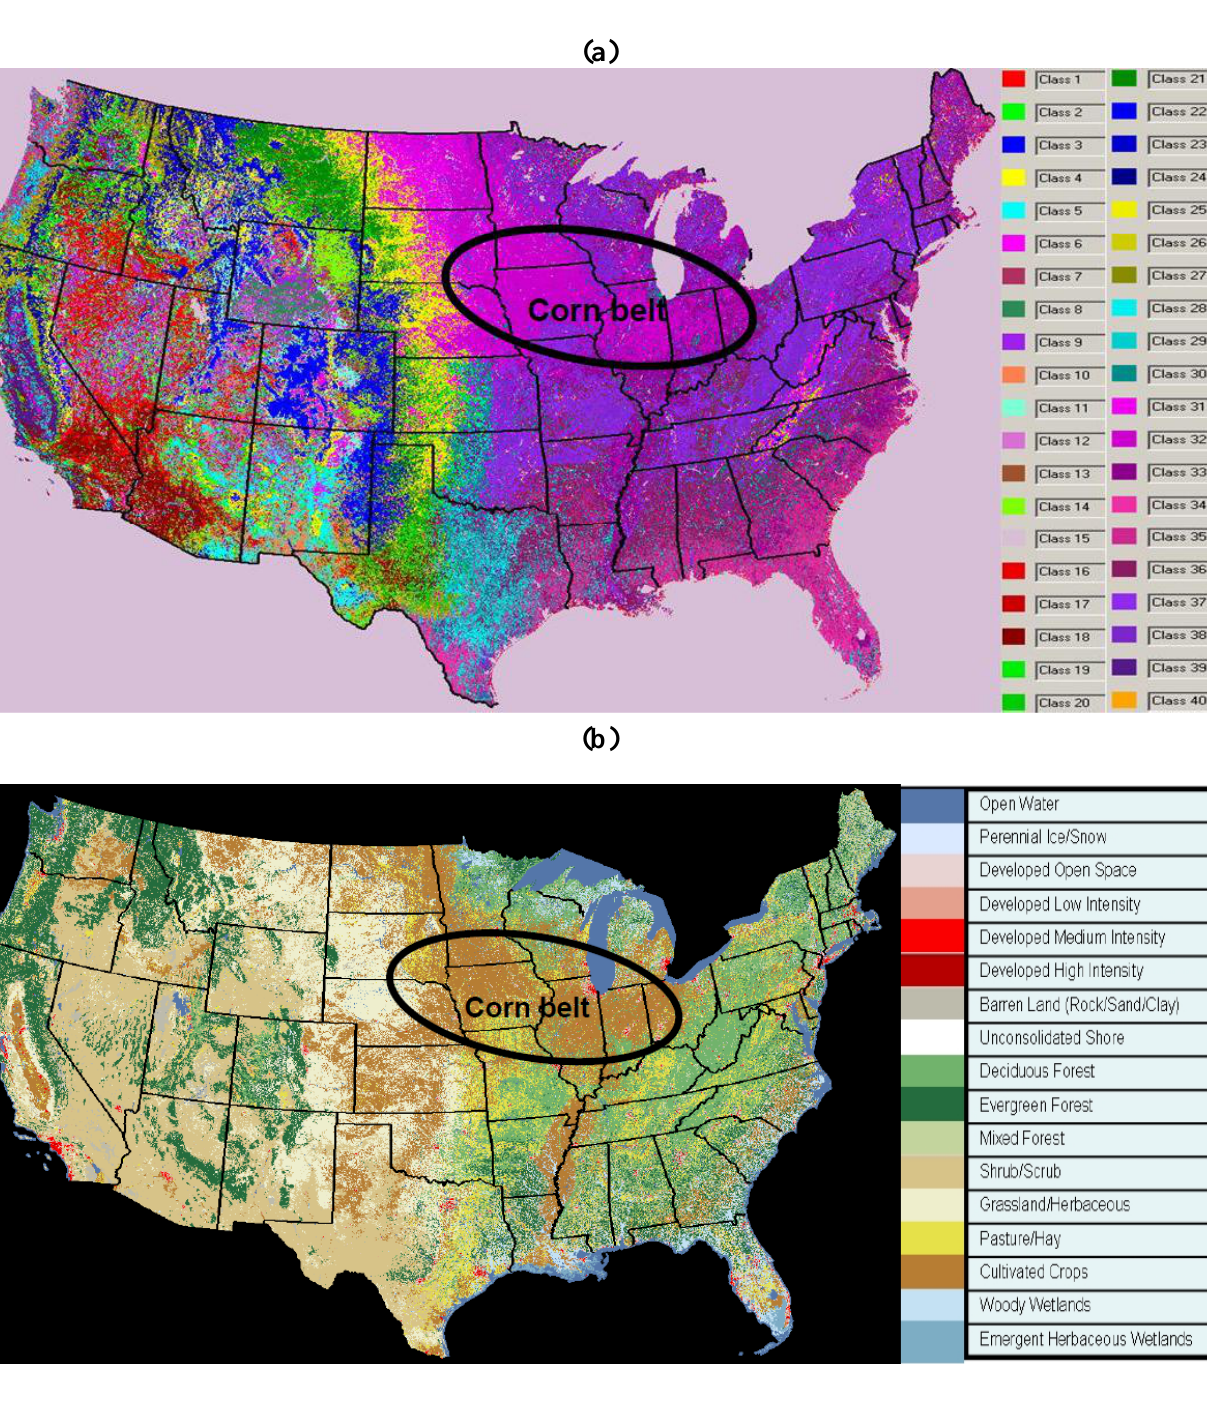
Figure 2. US pheno-class map derived from the median of the 5-year (2000–2004) of phenological metrics. The 2001 NLCD map was used to guide the number of ISODATA classes. (a) US pheno-class map; (b) 2001 NLCD map; (c) US ecoregion map delineated on the US pheno-class map in